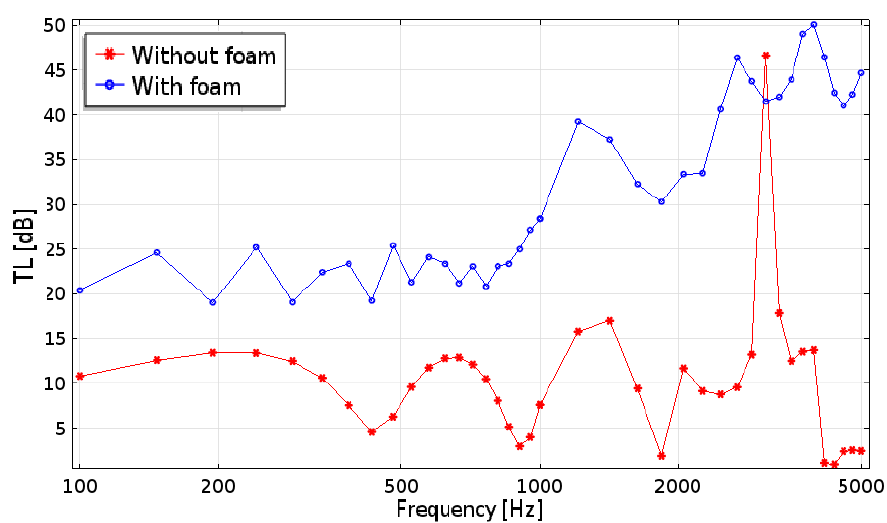
Figure 8. Transmission loss of the silencer for the secondary